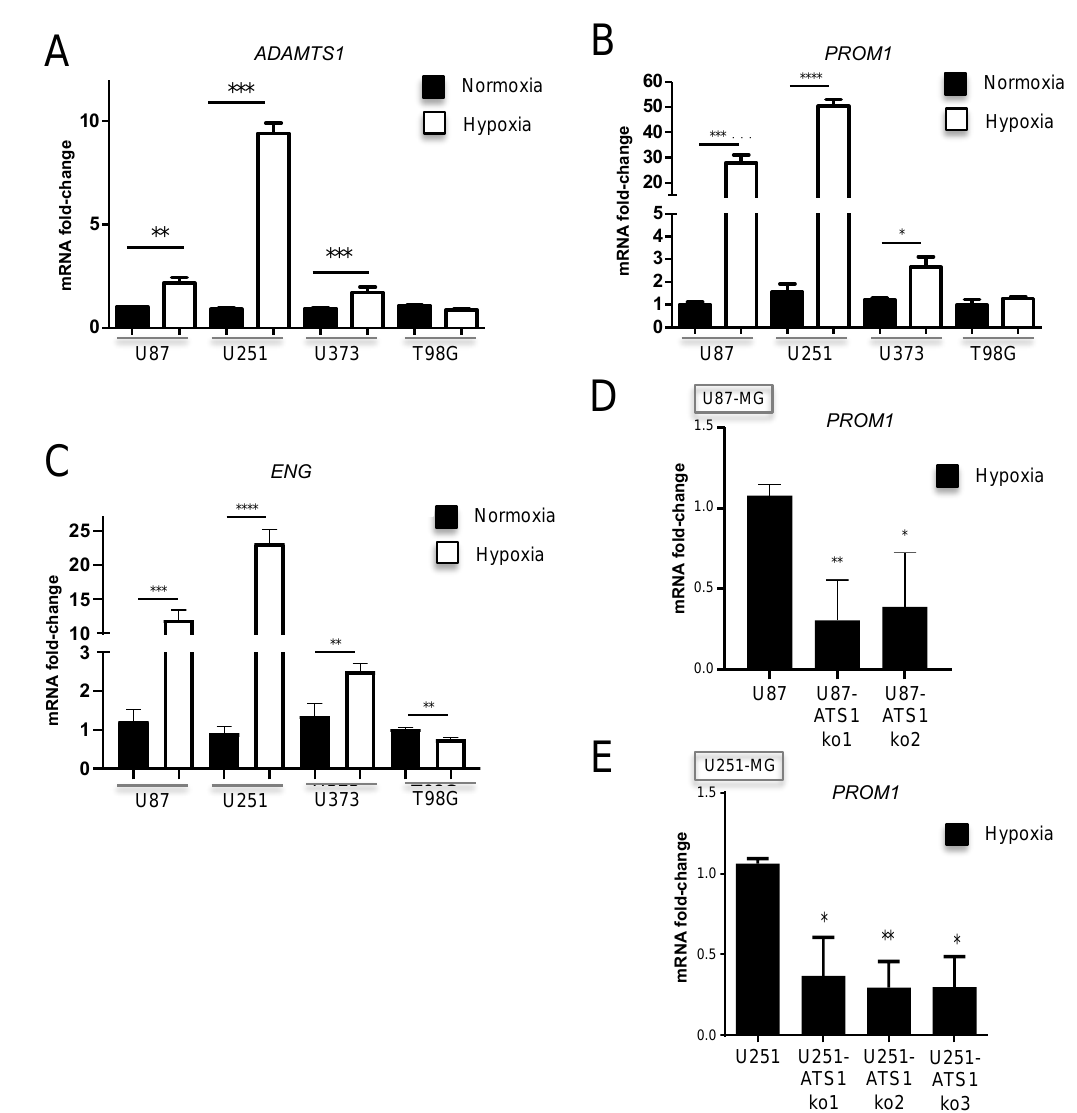
Figure 7. Evaluation of GBM cells under hypoxia and effect of ADAMTS1 knockout. ( A – C ) Graphs representing mRNA fold change expression of ADAMTS1 ( A ), PROM1 ( B ), and ENG ( C ) in normoxic and hypoxic cultures of GBM cells: U87-MG, U251-MG, U373-MG and T98G; ( D ) graph representing mRNA fold change expression of PROM1 in hypoxic cultures of WT U87-MG and U87-ATS1ko clones; ( E ) graph representing mRNA fold change expression of PROM1 in hypoxic cultures of WT U251-MG and U251-ATS1ko clones. ( n ≥ 3 samples for all cell lines and conditions) (****, p < 0.0001; ***, p < 0.001; **, p < 0.01; and *, p < 0.05).